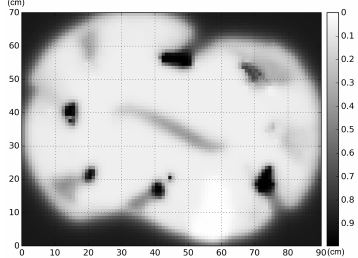
Figure 22. HMM parameter estimation of a 11 for unobserved space.